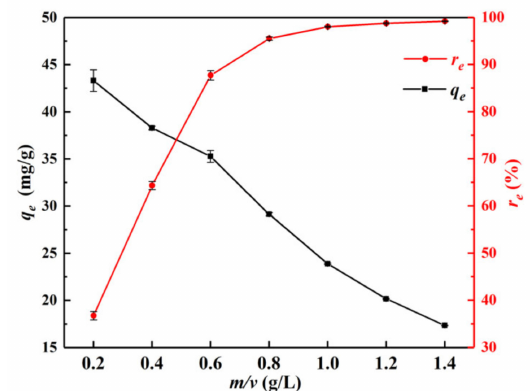
Figure 6. Changes in equilibrium adsorption capacity ( q e ) and removal rate ( r e ) of Cr(VI) with m / v